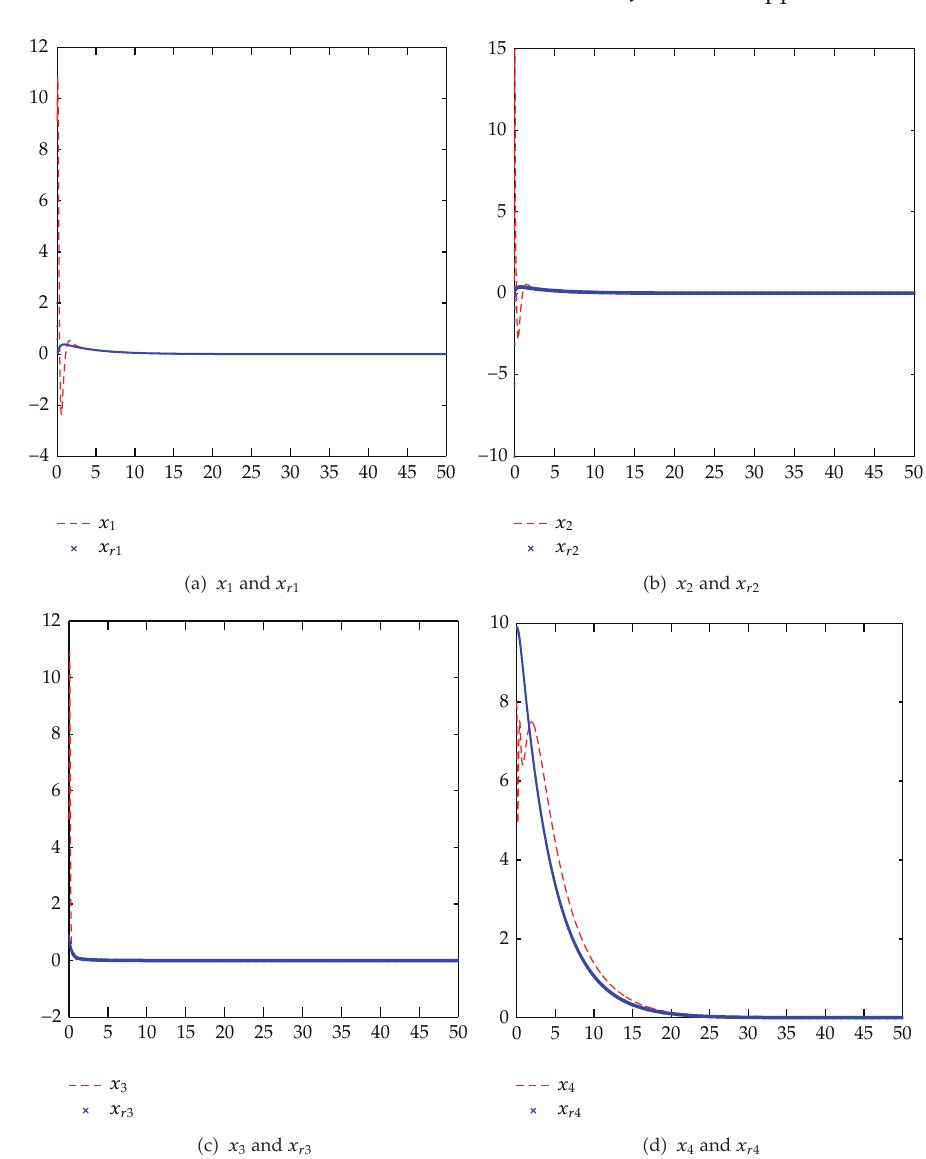
Figure 6: Comparison of the corresponding variables in the controlled hyperchaotic Lorenz system and its reference system: (cid:6) a (cid:7) x 1 and x r 1 ; (cid:6) b (cid:7) x 2 and x r 2 ; (cid:6) c (cid:7) x 3 and x r 3 ; (cid:6) d (cid:7) x 4 and x r 4 .